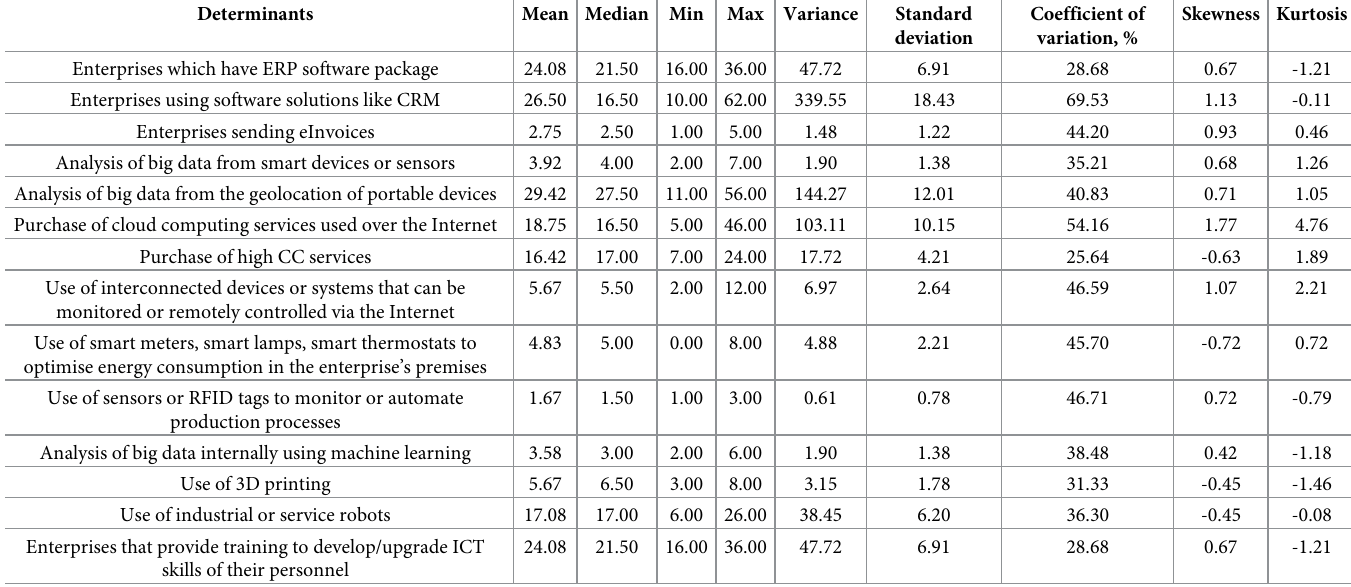
Table 7. Selected statistical parameters of the indicators determining the level of digital maturity among all enterprises in the CEE countries.